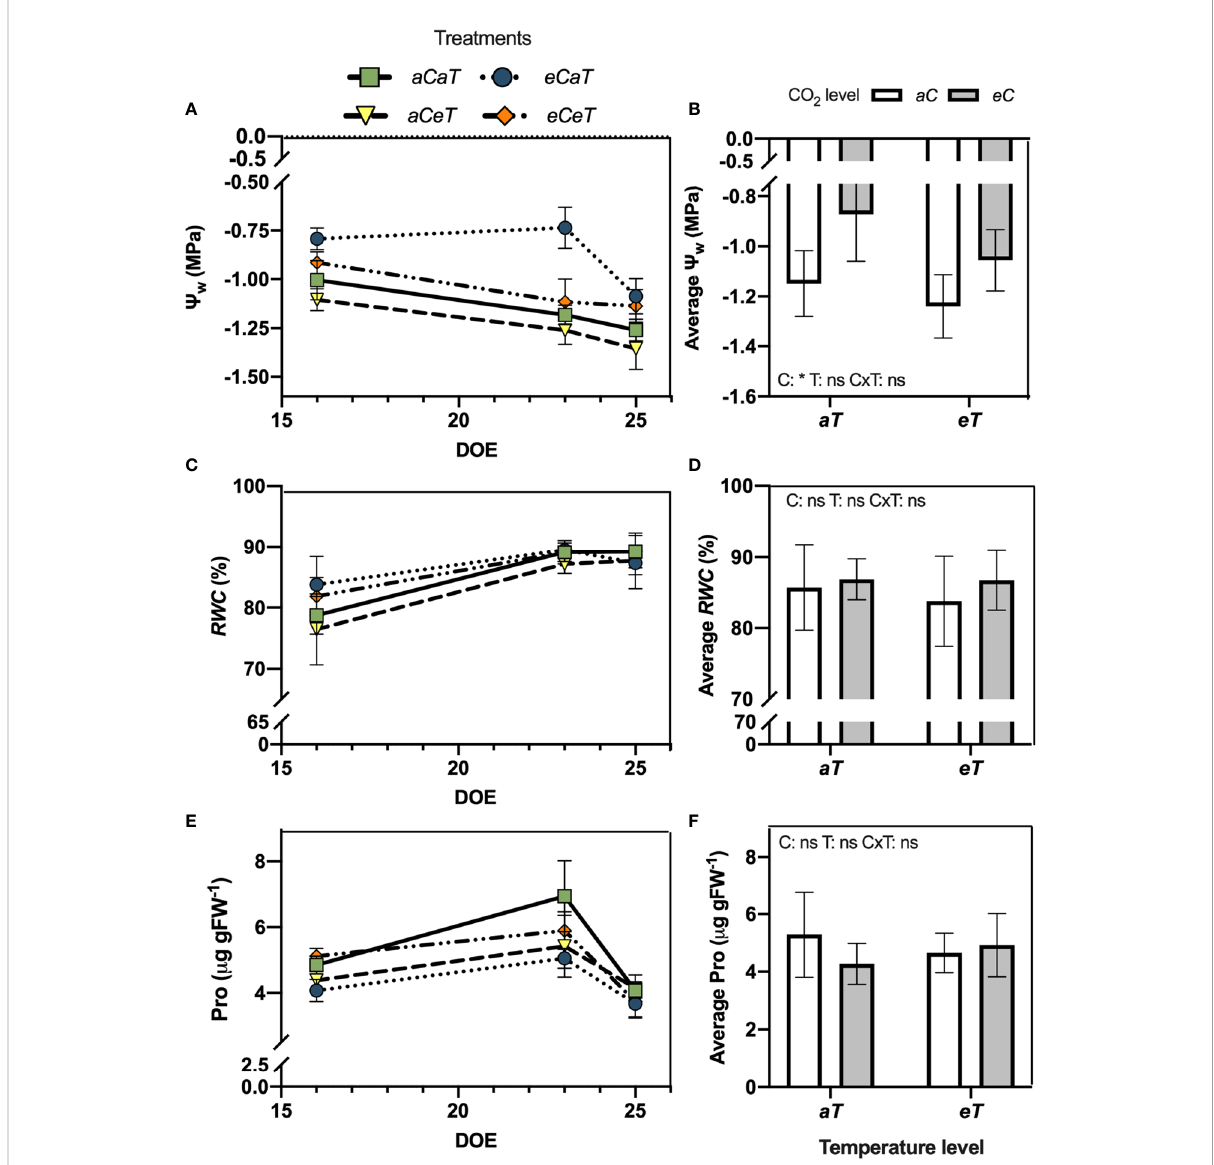
FIGURE 3 Water status and leaf proline content of fully expanded leaves of M. maximus during the experimental period in different levels of [CO 2 ] and temperature (left column) and average values (right column). Y w = water potential. RWC = relative water content. Pro = leaf proline content. DOE = day of the experiment. Treatments: aC (ambient CO 2 concentration), eC (elevated CO 2 concentration – 600 ppm), aT (ambient temperature), and eT (elevated temperature - 2°C above ambient temperature). ANOVA results are shown for diurnal averages: C: [CO 2 ] effect, T: temperature effect, C×T: interaction between C and T. *P < 0.05, **P < 0.01, ***P < 0.001, ns, non-signi fi